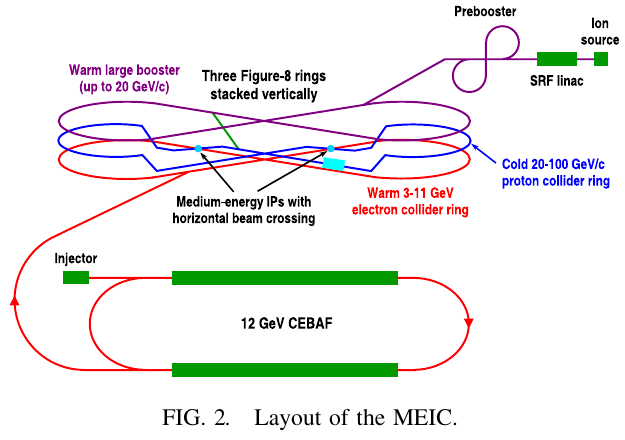
FIG. 2. Layout of the